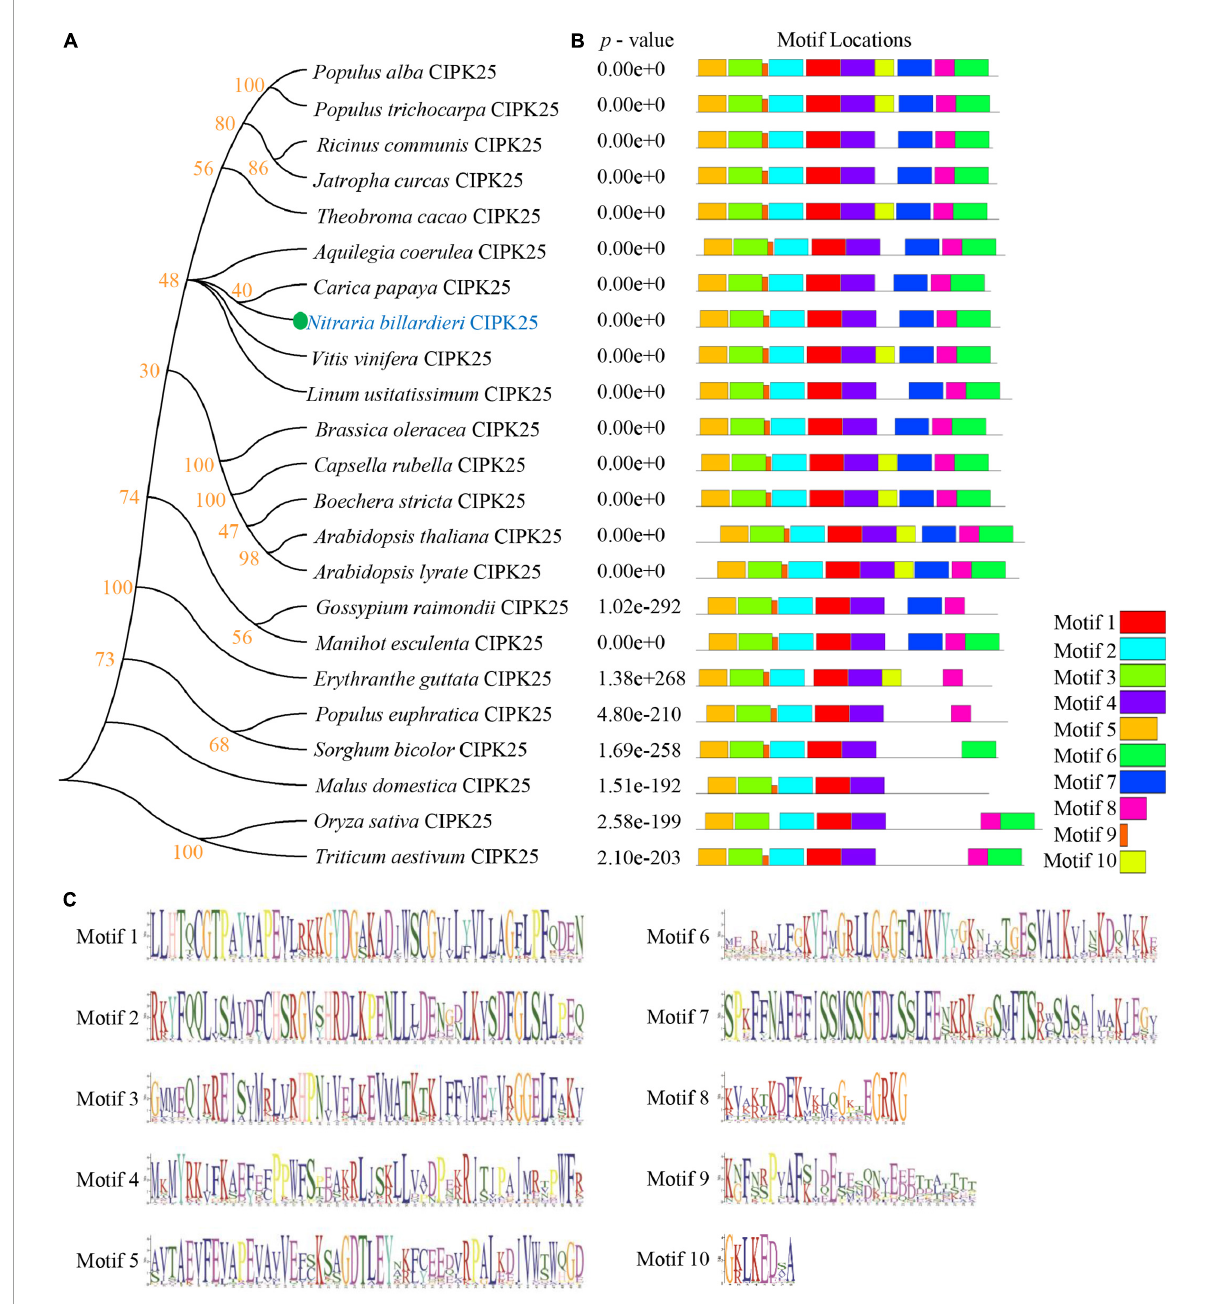
FIGURE2 Phylogenetic study and conserved motif analysis of CIPK25s. (A) The phylogenetic relationship between NbCIPK25 and 22 CIPK25 from indicating species. The tree was made using the Neighbor-Joining method in Mega 6 with 1,000 bootstraps. (B) The conserved motif distribution of CIPK25 proteins. The 10 boxes indicate conserved motifs with different colors. (C) Conserved sequences of the 10 motifs identified in CIPK25 proteins from Figure 2B .